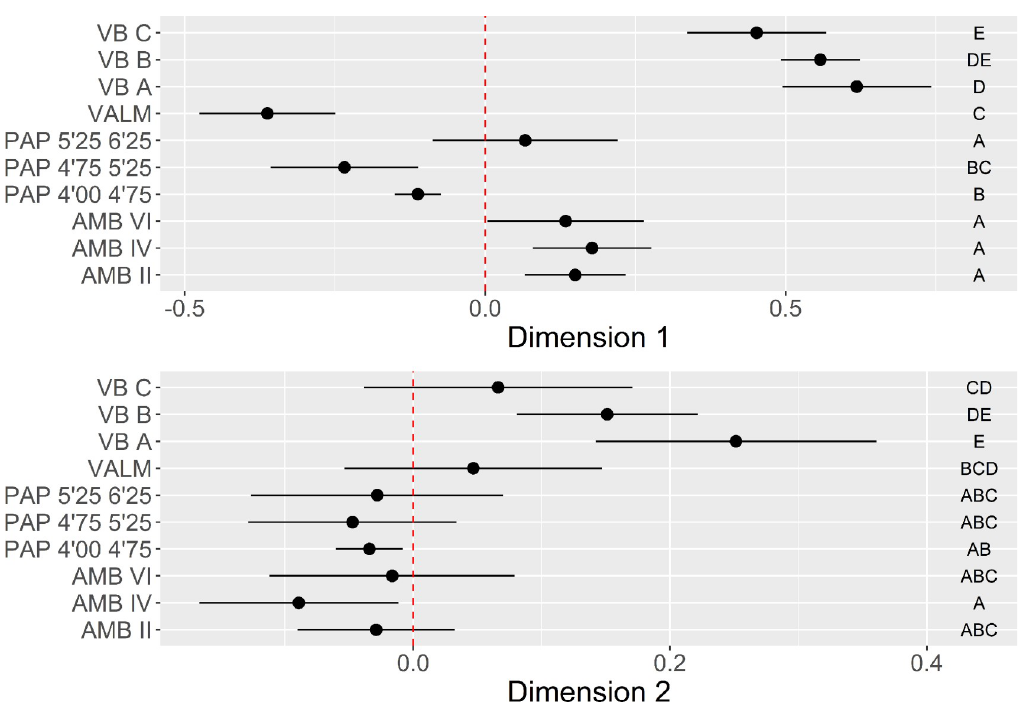
Fig 12. Elongated products multi-comparison bootstrap ANOVA. Error bars represent 95% confidence interval from the mean. Contexts sharing the same set of letters do not present statistically significant difference (p-value � 0.05).